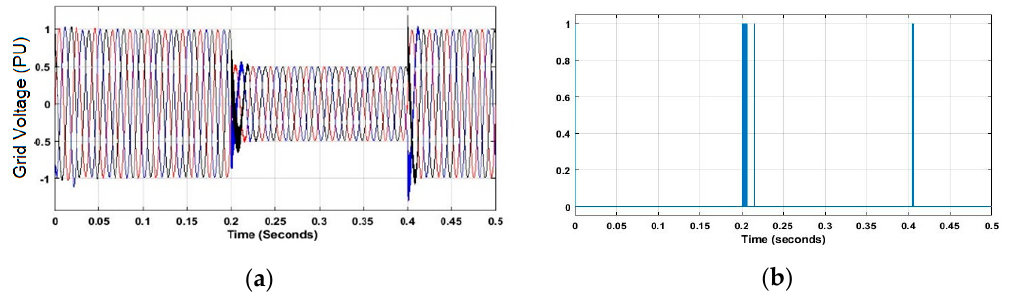
Figure 7. Voltage sag detection simulation results: ( a ) voltage sag waveform depth of 0.5 pu; ( b ) Figure7. Voltagesagdetectionsimulationresults: ( a )voltagesagwaveformdepthof0.5pu; ( b )detection detection output signal. output